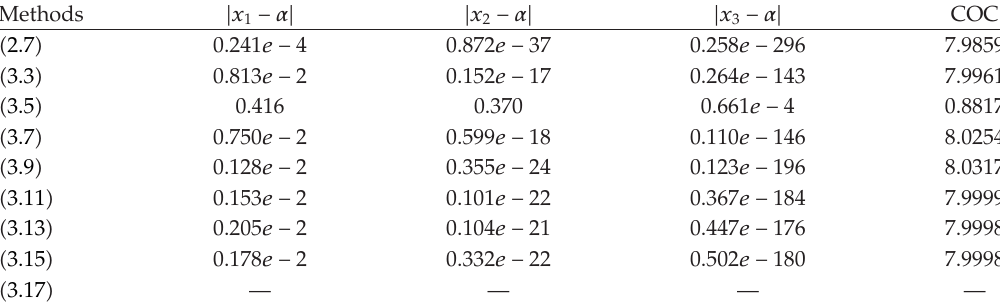
Table 3: Errors occurring in the estimates of the root of (cid:3) 4.3 (cid:4) by the methods described.